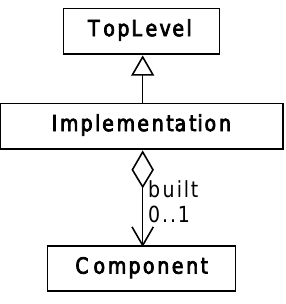
Figure 17: Diagram of the Implementation class and its associated